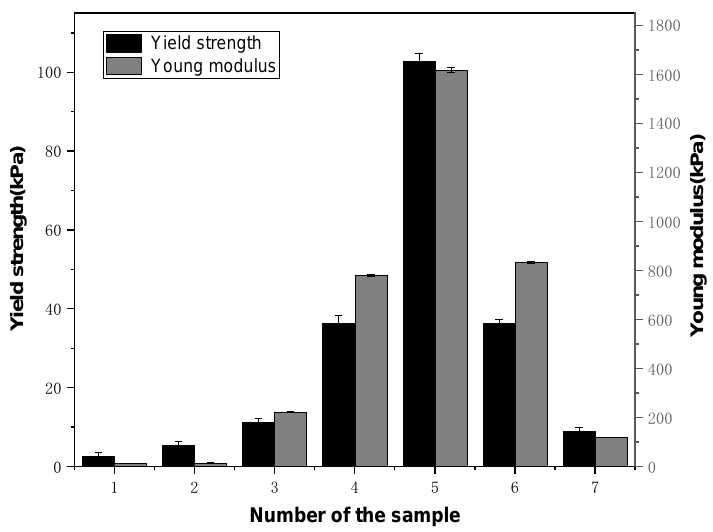
Figure 5. Yield strength and Young’s modulus of materials with different PVA contents.